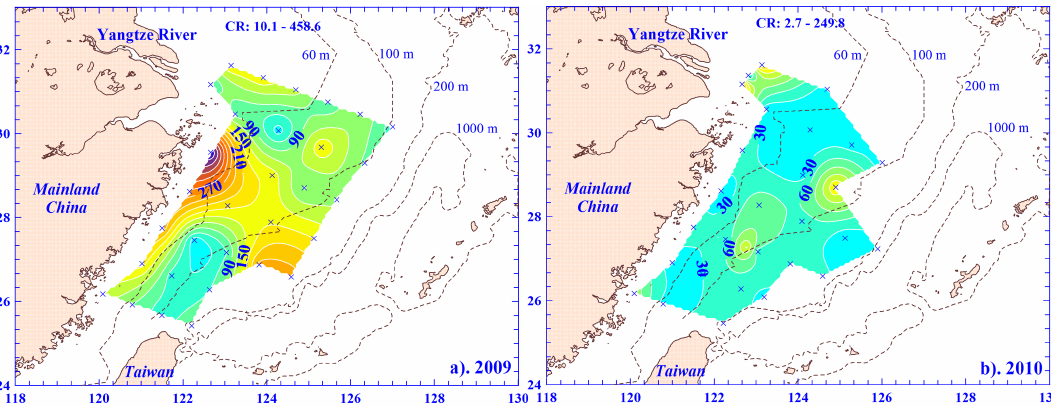
Fig. 7. Contour plots of plankton community respiration (CR) in the surface waters of the ECS in (a) 2009 and (b) 2010, with a contour interval of 30mg Cm − 3 d − 1